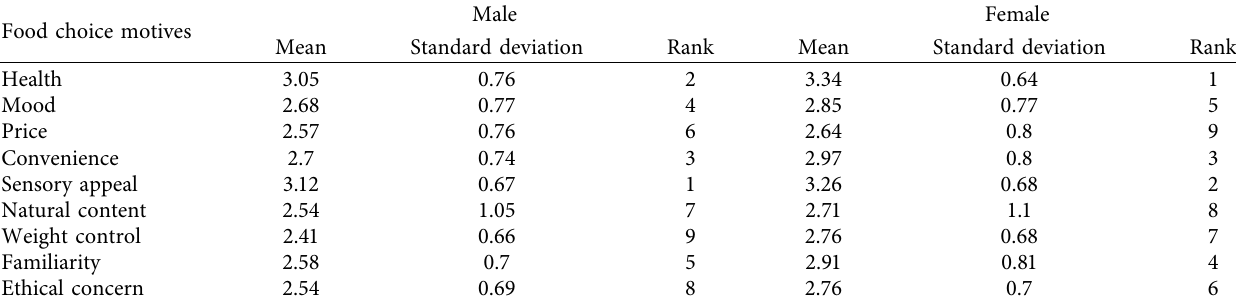
Table 3: Food choice motives with reference to